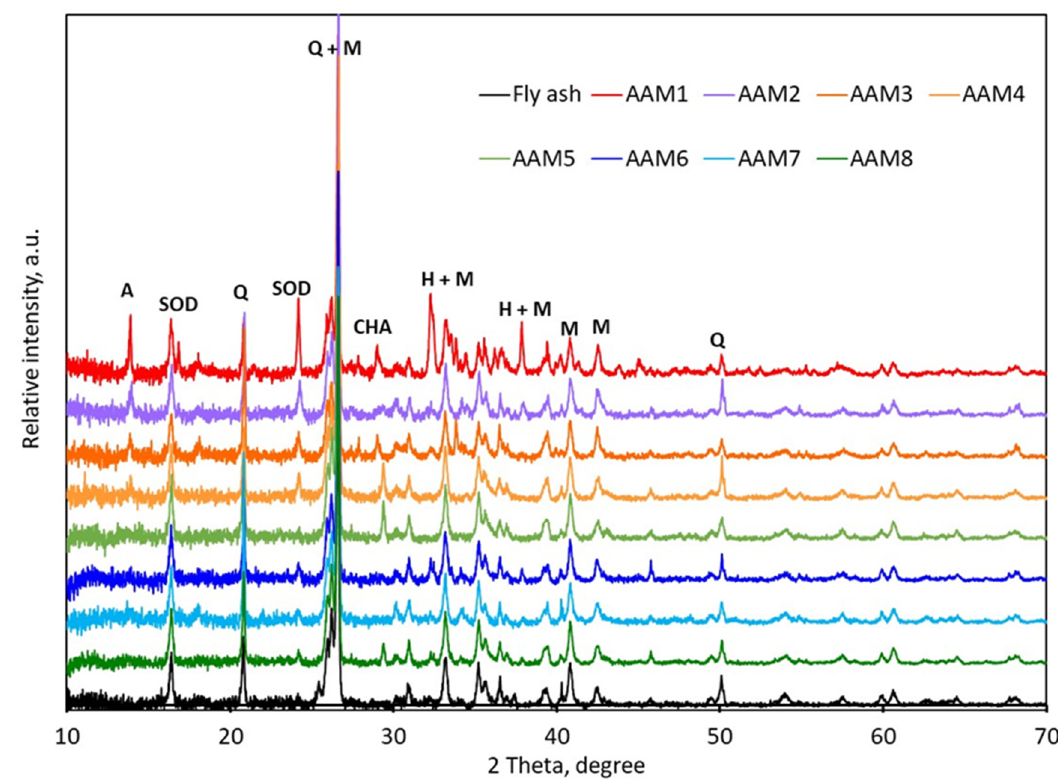
Figure 3. XRD patterns for fly ash and selected processed materials (Q—quartz, M—mullite, H— hematite, A—linde type A zeolite, CHA—chabazite, SOD—sodalite).